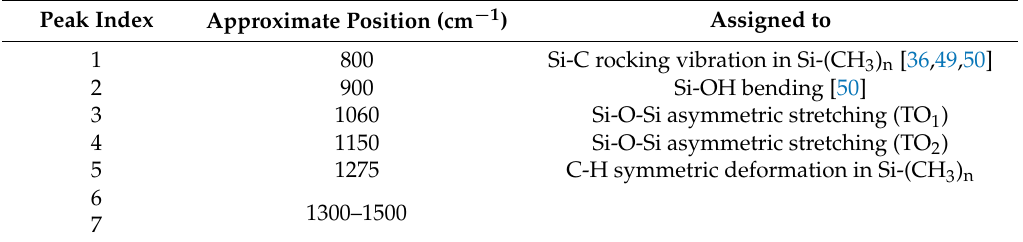
Table 3. Locations and assigned chemical groups for the synthetic curves presented in Figure 10.